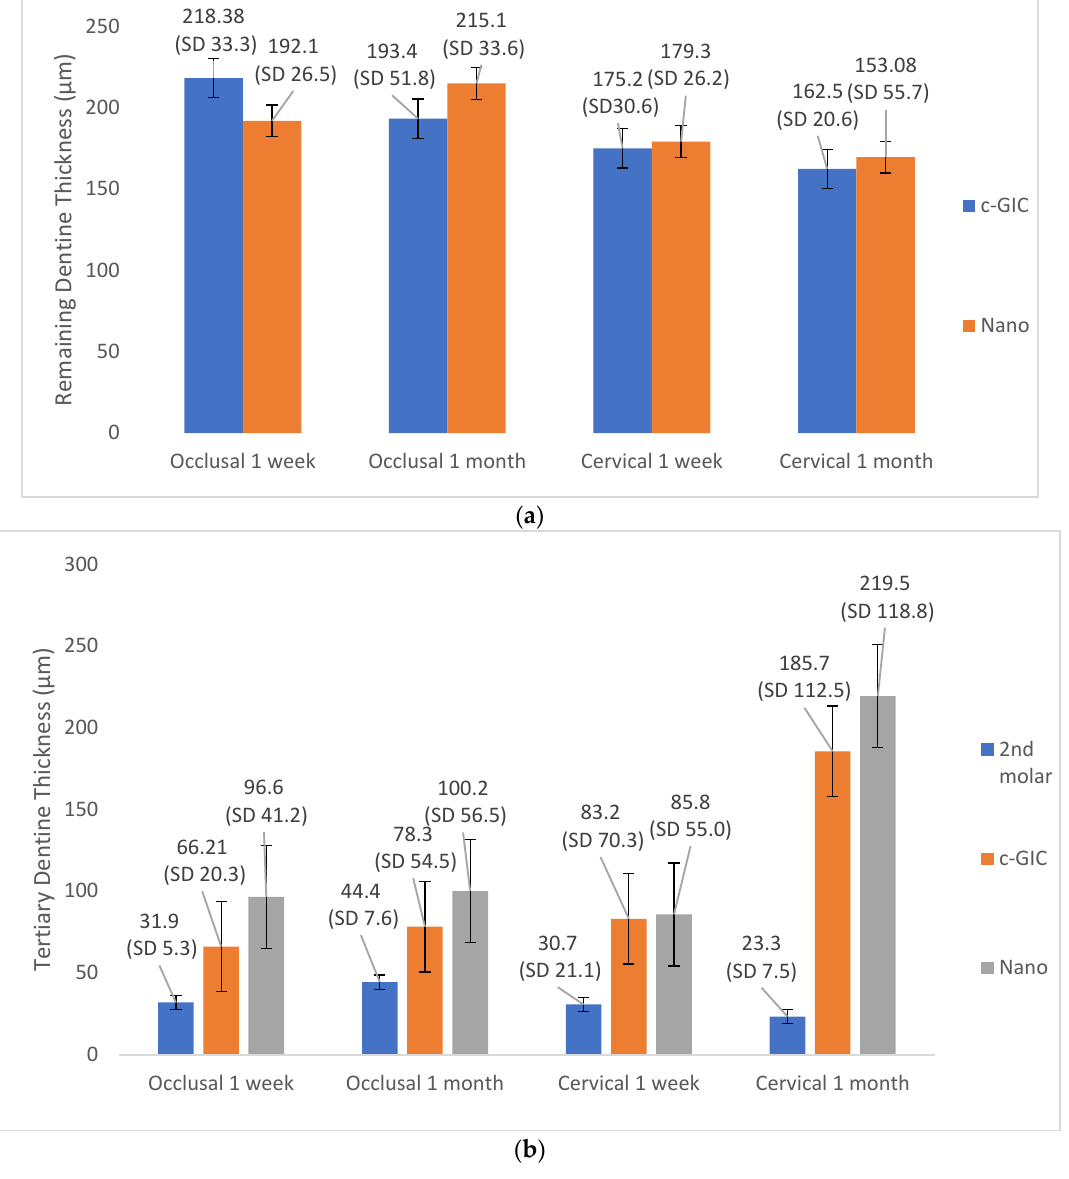
Figure 6. ( a ): Comparison of RDT values shown by c-GIC and nano-HA-SiO 2 -GIC in both cervical and occlusal restorations in different interventional periods. ( b ): Comparison of TDT values among 2nd molar, c-GIC, and nano-HA-SiO 2 -GIC for both materials at different time intervals.